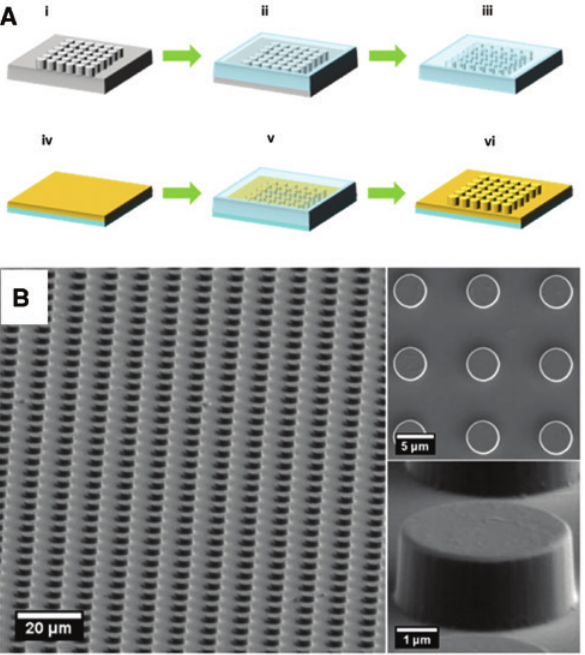
Figure 16: Preparation of solvent-assisted prestructured azomate- rial